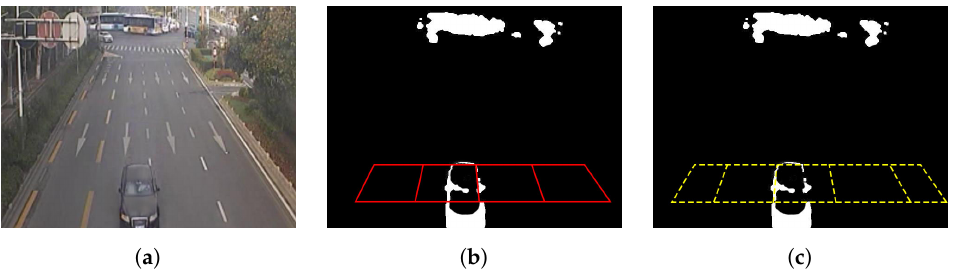
Figure 22. Example of missed counting. ( a ) Example frame under RGB mode. ( b ) Detection result set with primary loops. ( c ) Detection result set with secondary loops.